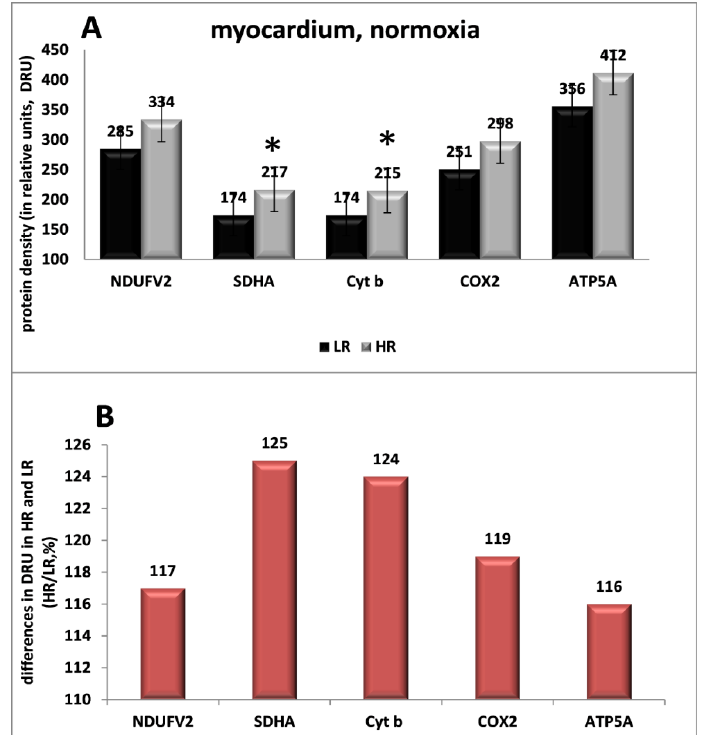
Figure 1. ( A ). The content of the catalytic subunits of mitochondrial complex enzymes MC I – V in the myocardium of HR and LR rats under normoxic conditions (protein density in relative units, DRU): NDUFV2-MC I; SDHA-MC II; Cyt b-MC III; COX2-MC IV; ATP5A-MC V. ( B ). The difference in protein content in the measured subunits in the myocardium of HR and LR rats (HRDRU/LRDRU, %). (*) the differences between the groups are significant, p <